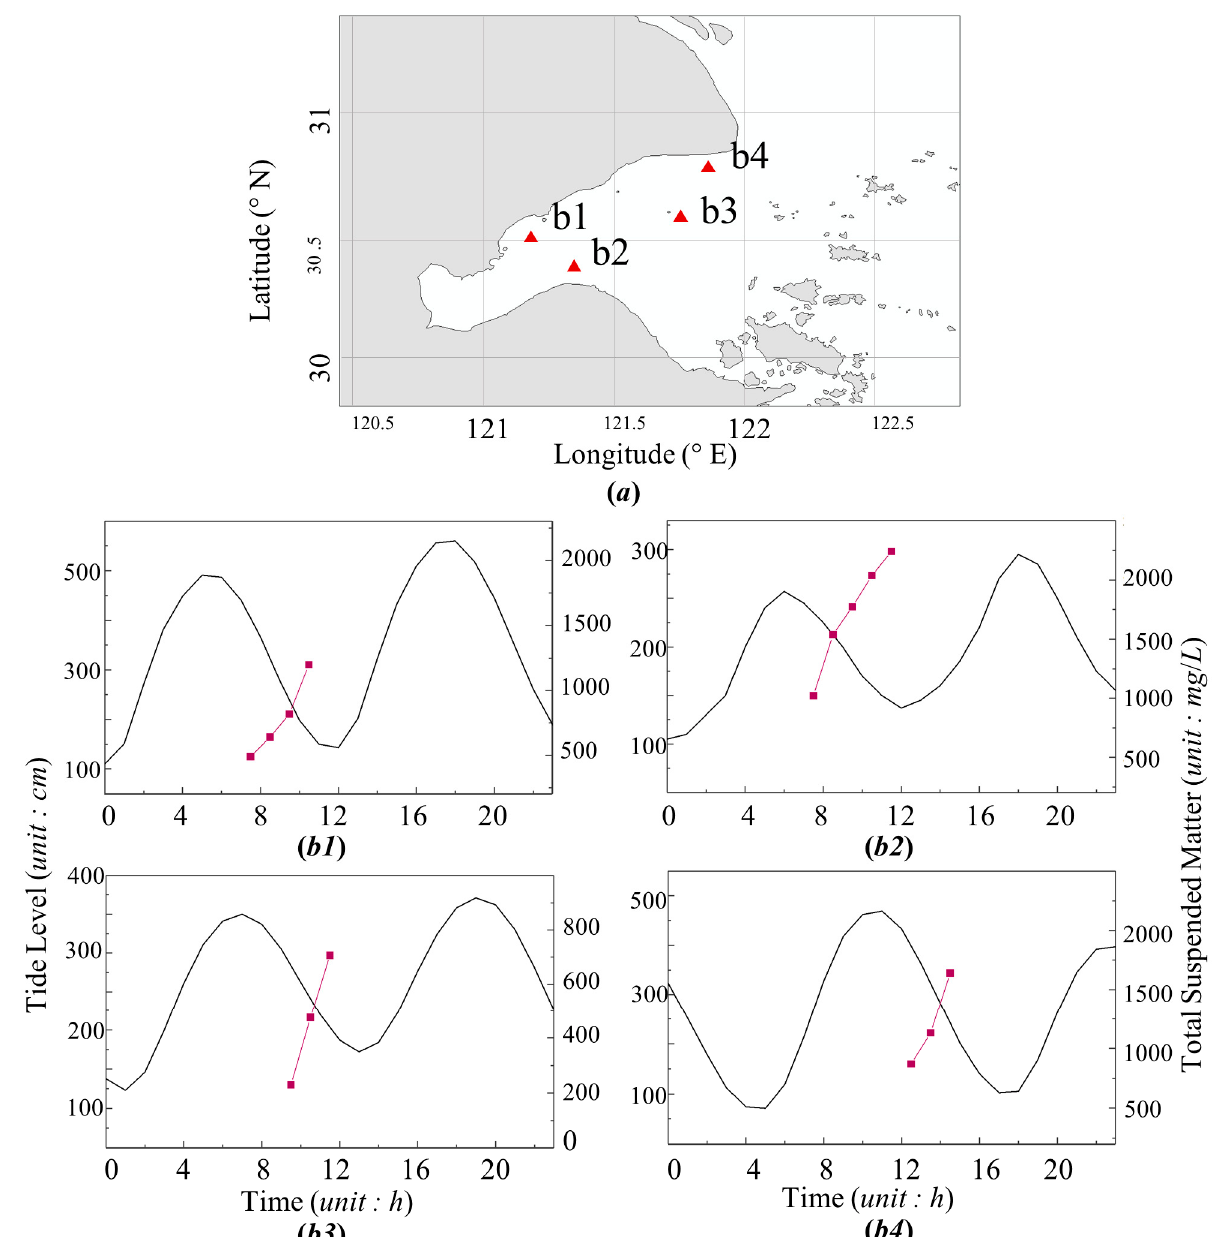
Figure 8. The hourly variation of TSM concentration measured at ebb tide in the HZB. ( a ) The locations of in-situ sampling stations for TSM concentration during the 2011 cruise are indicated with a red triangle, and the hourly variations of TSM concentration with red dot lines at the station ( b1 ) on 2 December 2011, the station ( b2 ) on 3 December 2011, the station ( b3 ) on December 4, 2011, and the station ( b4 ) on 9 December 2011. TSM concentration incremental histogram (Figure 7a) showed the contribution of different regions to the TSM concentration change in HZB. The left side of the Figure 7a is the situation inside HZB. The two transects at the neck of HZB (120°50 ′ E, 121° E) ac- counted for the largest proportion (43%), that is, the increment of TSM concentration in these regions directly affected the increment of TSM concentration inside HZB. In addi- tion, the average TSM concentration in these two regions ((655.5 ± 5.7) mg/L, (507.4 ± 7.4) mg/L) was significantly higher than the total average TSM concentration inside HZB ((371.8 ± 1.8) mg/L), indicating that the variation of TSM concentration in the high TSM concentration region played a dominant role in the variation of TSM concentration in- side HZB (Figure 7b). However, the increment of the five transects (121°10 ′ E, 121°20 ′ E,